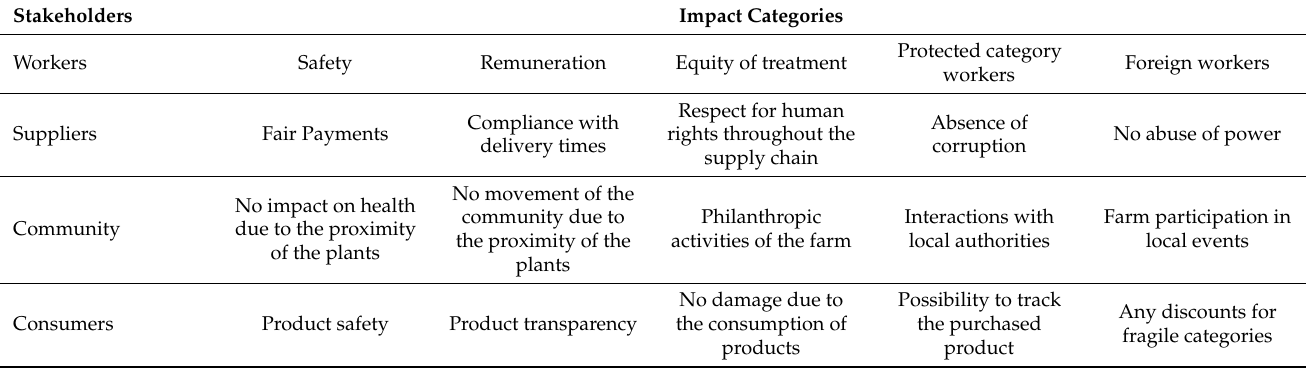
Table 3. Social Life Cycle Assessment: stakeholder categories and impact categories